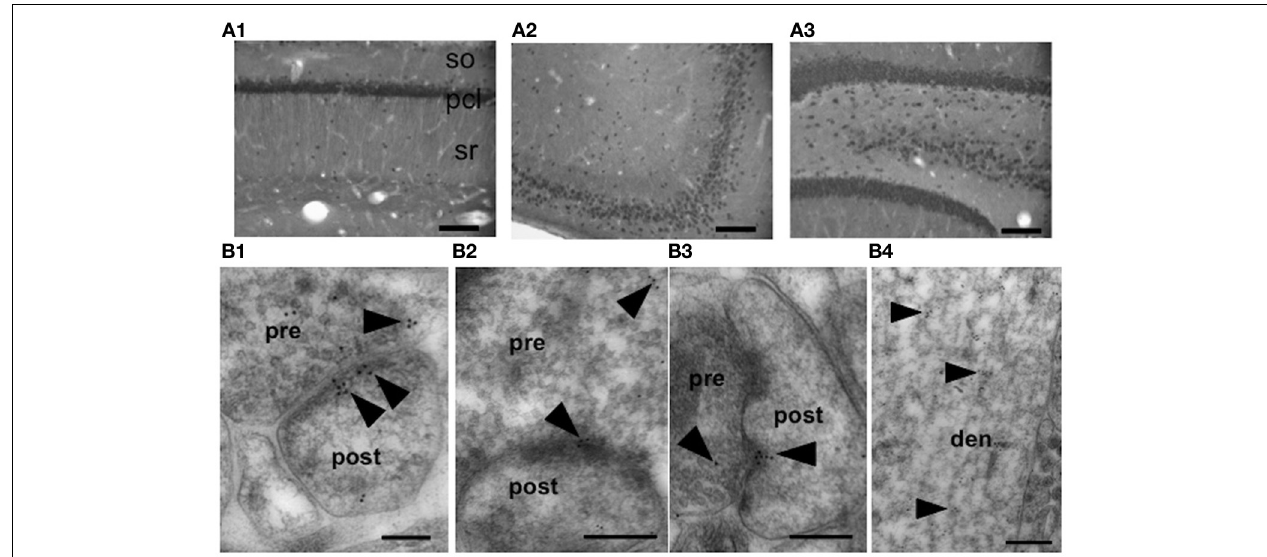
FIGURE 2 | Localization of activin type IB receptor in the rat hippocampus. (A) Immunohistochemical staining of the hippocampal slice (coronal section) of adult male rat probed with anti-activin receptor IgG. (A1) CA1, (A2) CA3, (A3) DG. Scale bar, 200 μ m. so, stratum oriens; pcl, pyramidal cell layer; sr, stratum radiatum. Representative images are shown from approx. 18 photographs from 6 independent slices from 3 animals. (Supplementary Figure 2A4) No staining after preadsorption treatments with activin receptor. (B) Immunoelectron microscopic analysis, using anti-activin receptor IgG, of the distribution of activin receptor within the axospinous synapses of the hippocampal principal neurons in the stratum radiatum of CA1 (B1) , stratum radiatum